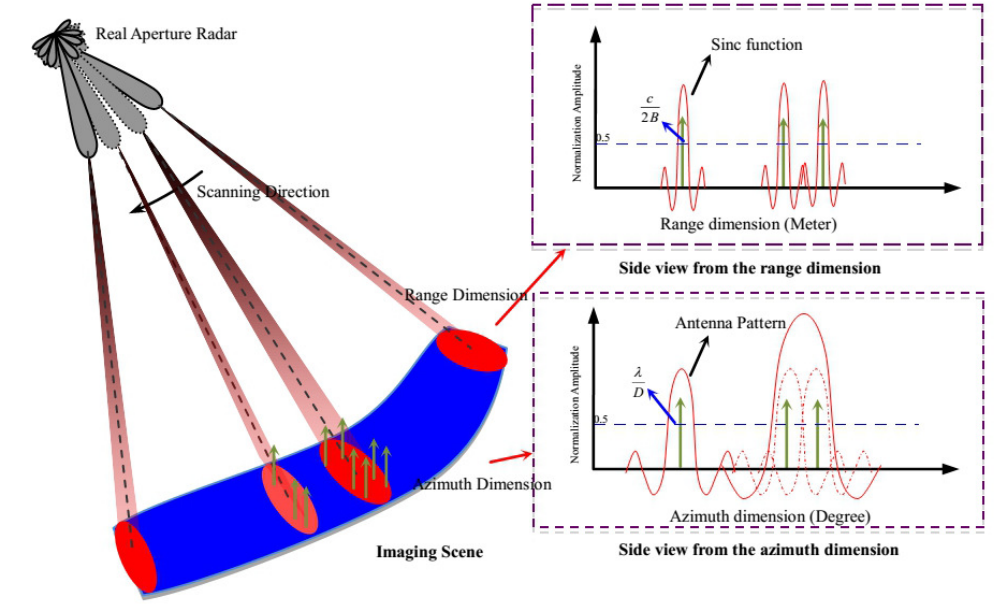
Figure 1. Geometric model of the real aperture scanning